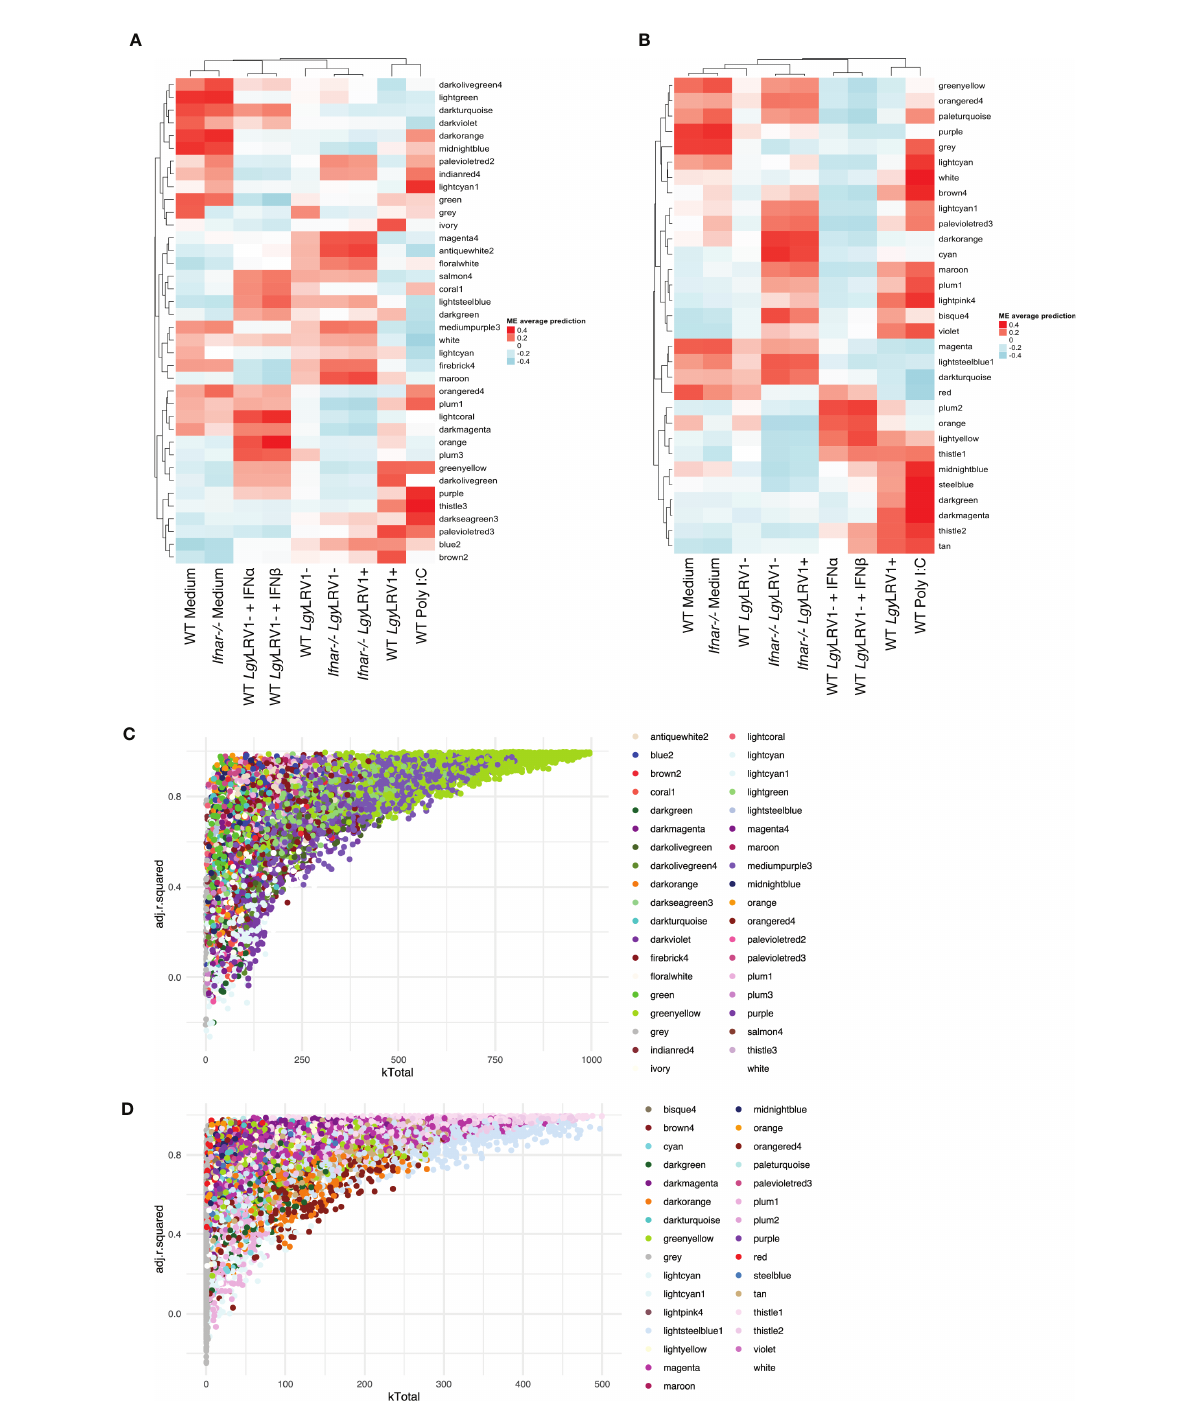
FIGURE 4 Type I IFNs play a preponderant and central role in the infection mounted by macrophages toward Lgy LRV1+. (A) Heatmap of the average predictions of the fi tted linear model on each ME at the 8-h time point in WT + Ifnar -/- analysis. (B) Heatmap of average predictions of the fi tted linear model on each ME at the 24-h time point in WT + Ifnar -/- analysis. (C) Scatter plot of kTotal (whole network connectivity) against adjusted R-squared for all genes in an 8-h network in WT + Ifnar -/- analysis. Genes are colored according to the module they belong to. (D) Scatter plot of kTotal (whole network connectivity) against adjusted R-squared for all genes in a 24-h network in WT + Ifnar -/- analysis. Genes are colored according to the module they belong